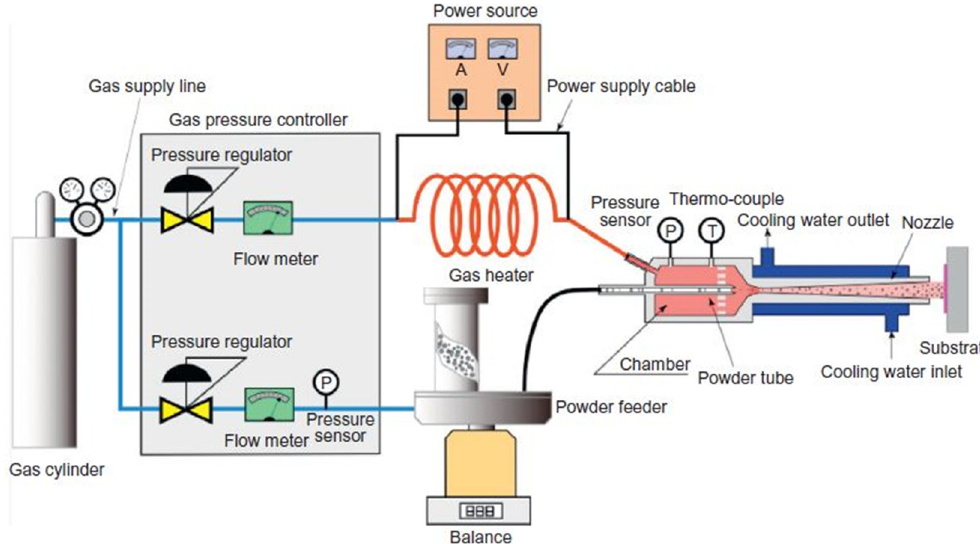
Figure 1: Set up of CS coating system [ 1 ]